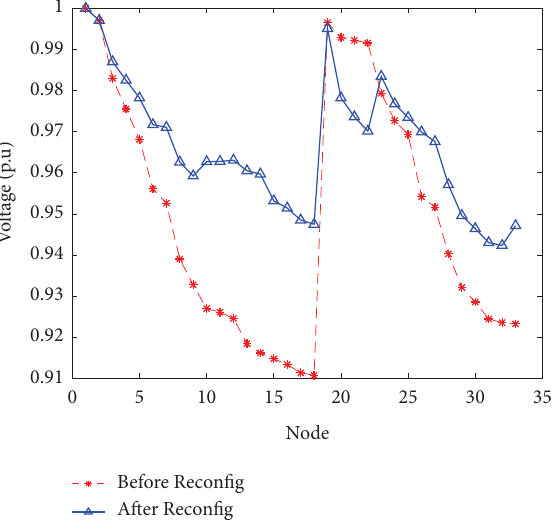
Figure 7: Voltage profle of 33-bus system for normal